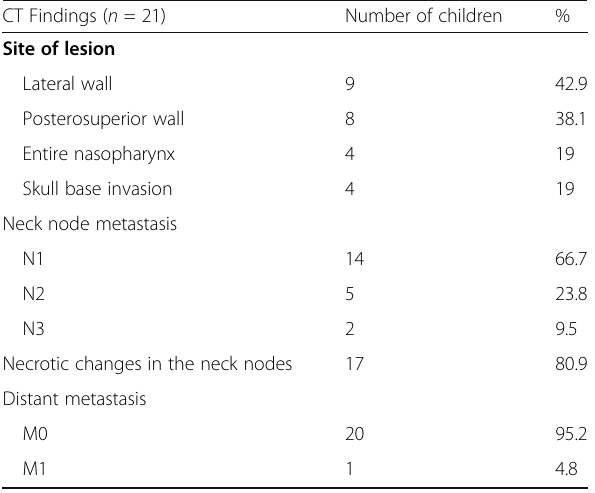
Table 4 Imaging in pediatric NPC